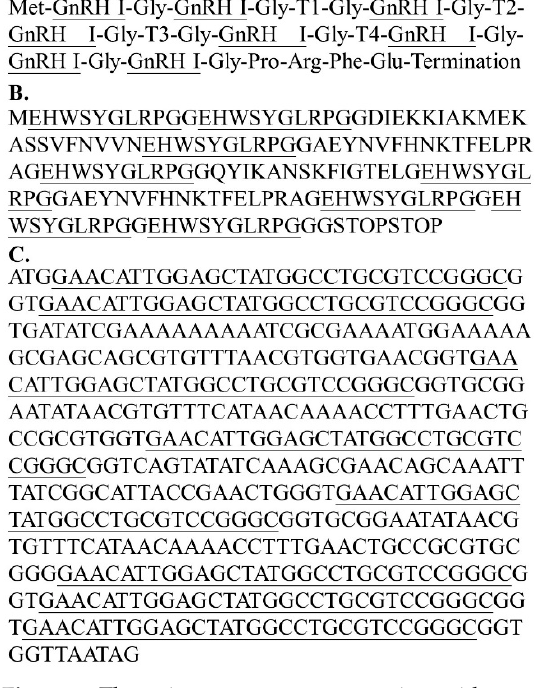
Figure 1. The epitope arrangement, amino acid sequence, and nucleotide sequences of the fusion protein were designed as the gonadotropin-releasing hormone (GnRH) antigen in our GnRH-based vaccine. The design of the fusion protein was modified from that used by Talwar, et al. [37]. ( A ) The multimeric structured fusion protein of the vaccine included eight units of GnRH I decapeptide and four small peptides recognized as T-cell epitopes (T1, T2, T3, and T4). ( B ) The amino acid sequence of multimeric GnRH I decapeptide linked to T-cell epitopes. ( C ) Nucleotide sequence of multimeric GnRH I gene linked to T-cell epitopes.